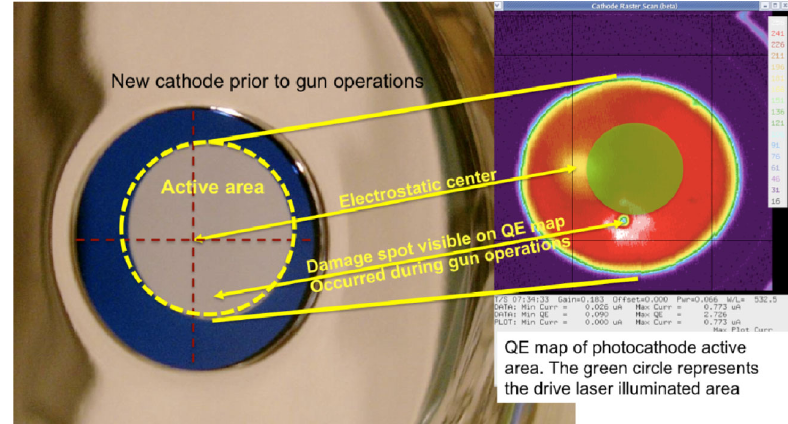
FIG. 1. Photograph and quantum yield map (right) of FEL photocathode. The active area is 16 mm in diameter. The blue region is the anodized area. The laser-illuminated area is the 8 mm diameter shown as the green circle on the quantum yield